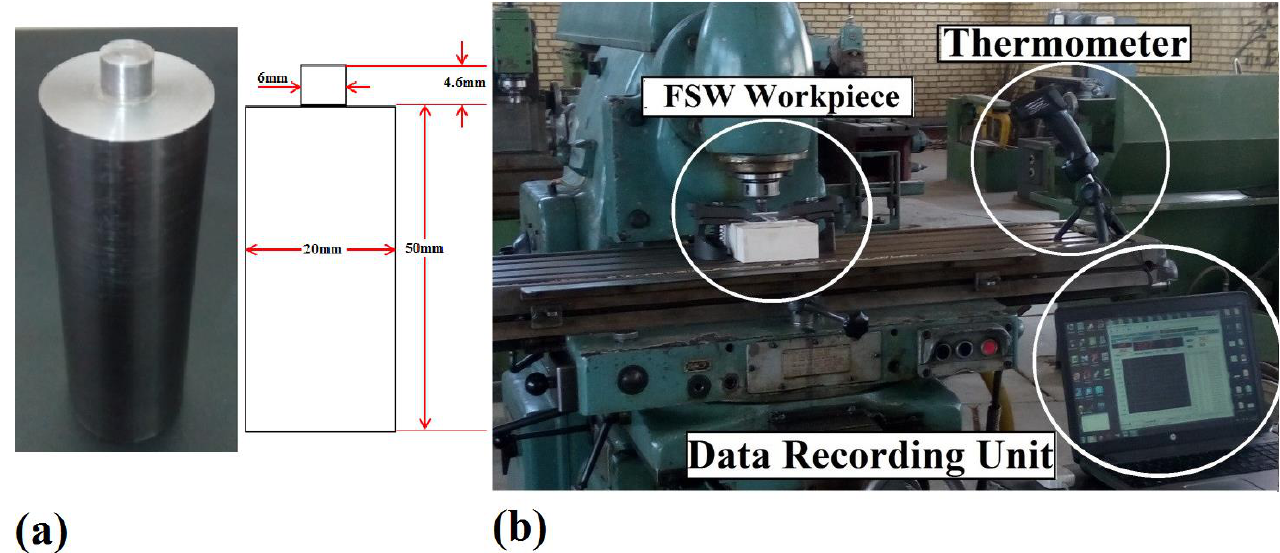
Figure 2. ( a ) The used tool in the friction stir welding (FSW) process, ( b ) the equipment used to record temperature in the experiment.